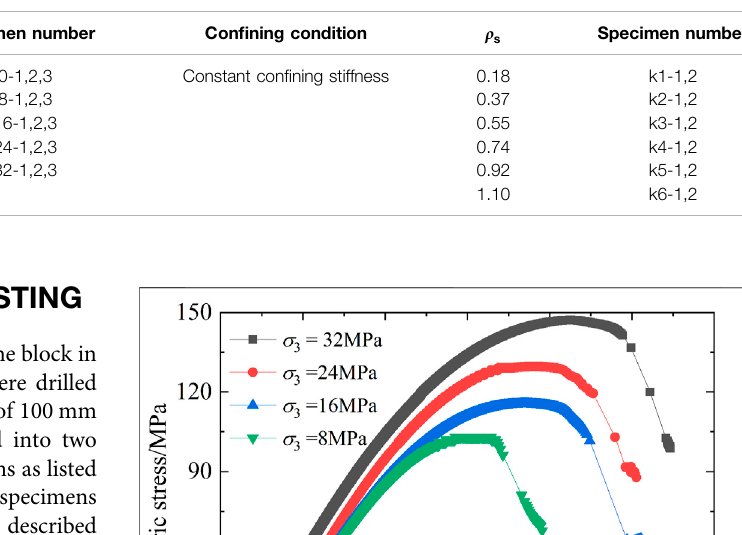
TABLE 2 | Two groups of specimens with different con fi ning conditions.